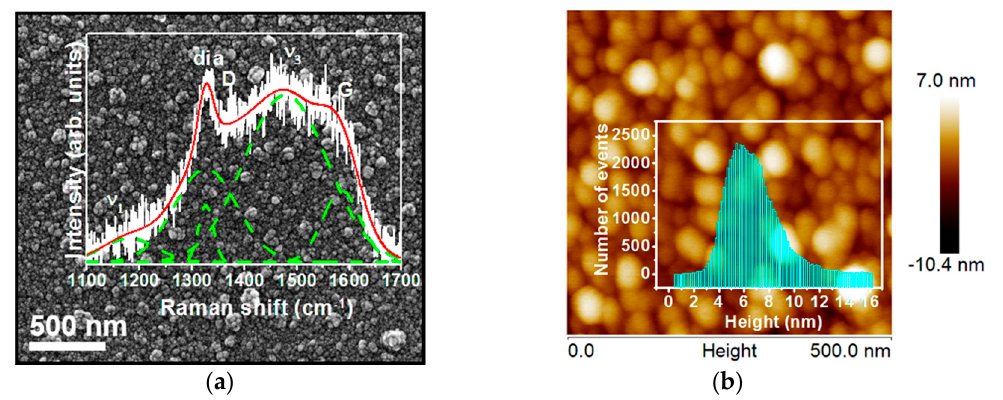
Figure 2. ( a ) SEM and ( b ) AFM micrographs of the NCD/Cr/LNO films, showing a small and uniform grain size distribution in the films. The inset in ( a ) shows the Raman spectrum ( λ = 488.0 nm), whereas the inset in ( b ) shows a histogram for the grain size distribution of the films.